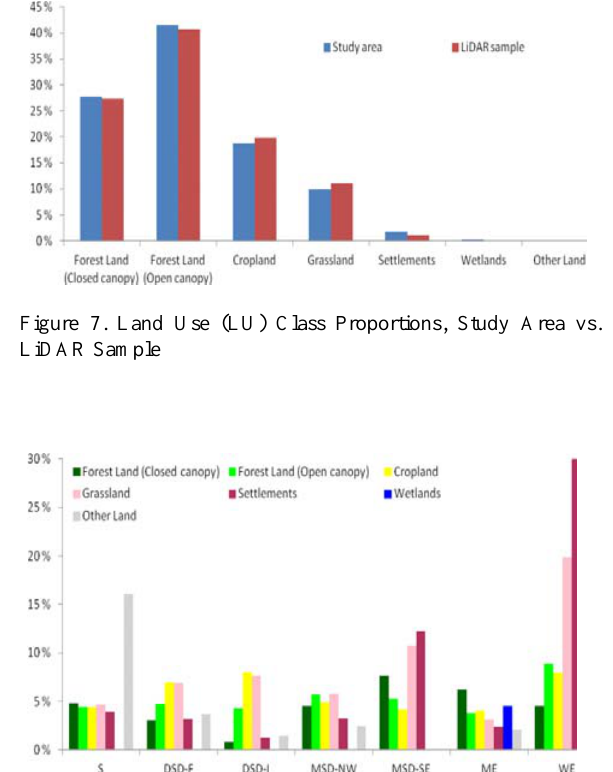
Disregarding the ecological zones, the systematic LiDAR sample design captures different LU classes over the study area efficiently (Figure 7). The same applies to closed and open canopy forest classes when different ecological zones are studied independently (Figure 8). Within the DSD-I zone the sampling rate (0.8%), for closed forests, remain remarkably below the average prevalence ratio of 4.9% for this zone. The Pearson’s Chi-Squared test results indicate that the sample proportion of closed and open forests is significantly lower than expected at 95 % confidence level in case of DSD-I and WE (Table 3).